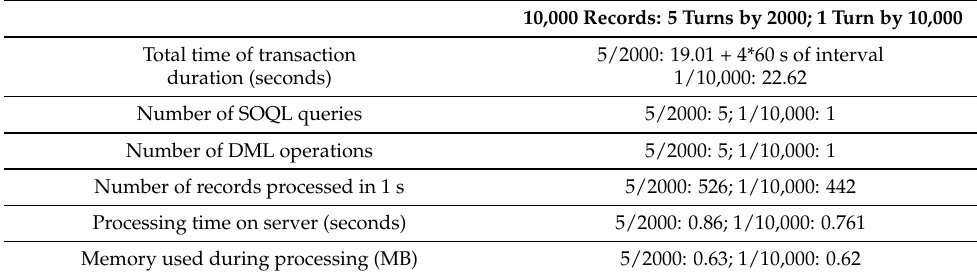
Table 11. Apex Schedulable processing results for delete